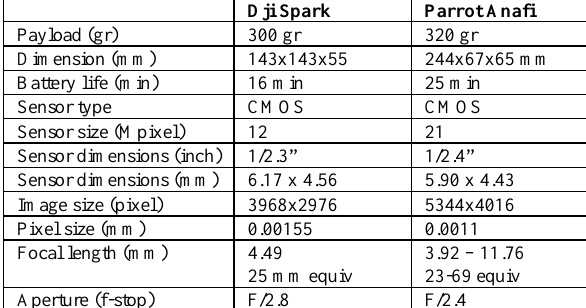
Table 1. Photographic characteristics of the most